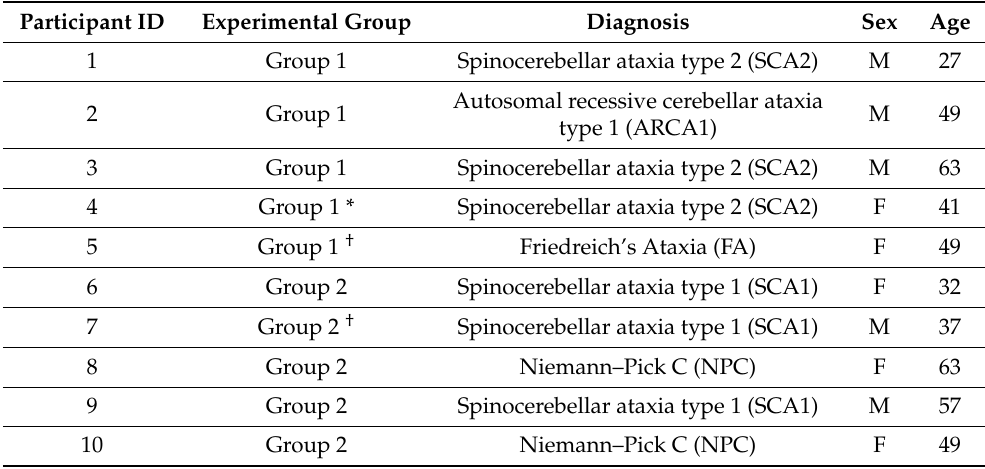
Table 1. Demographic information of participants. Group 1 received vibrotactile SA during the first six weeks of home-based training. Group 2 received vibrotactile SA during the second six weeks of home-based